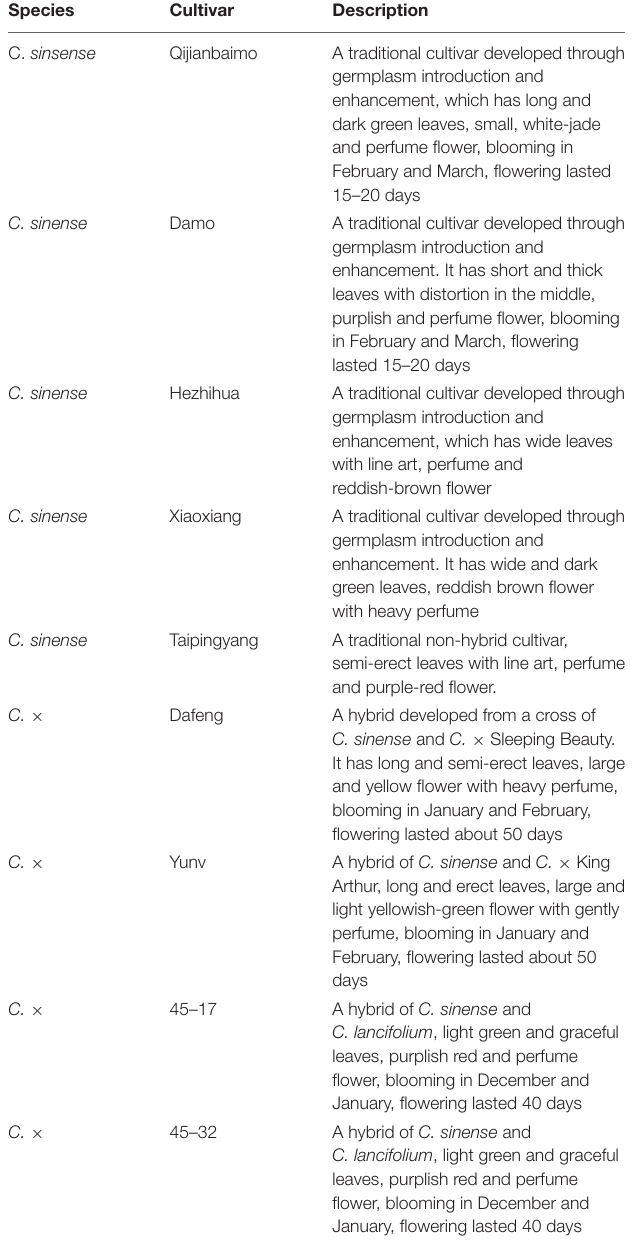
TABLE 1 | Cymbidium cultivars used for evaluation of 2 n gamete formation. Species